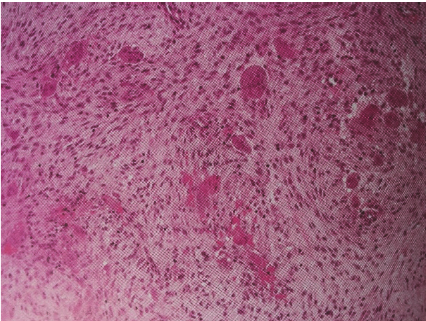
reported in the literature and presented with mental retarda- tion, short stature, gingival fibromatosis, and epilepsy. Jaffe- Campanacci syndrome is a rare syndrome and includes uni- lateral nonossifying fibromatic lesions. The radiologic charac- teristic of cherubism is more diagnostic than histopathologic [1, 12, 13,